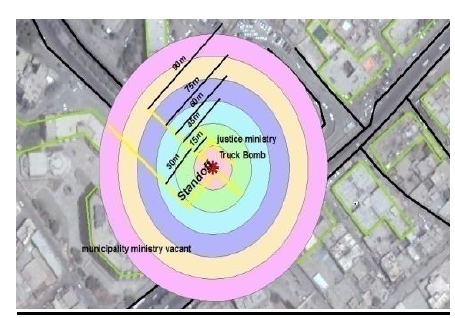
Fig. 11: The initial blast wave pressure distance from truck bomb with 15 meter multiply.